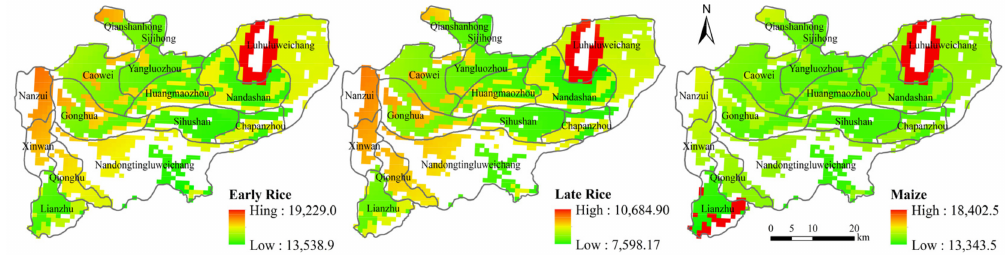
Figure 4. Land production potential of the main grain crops in Yuanjiang